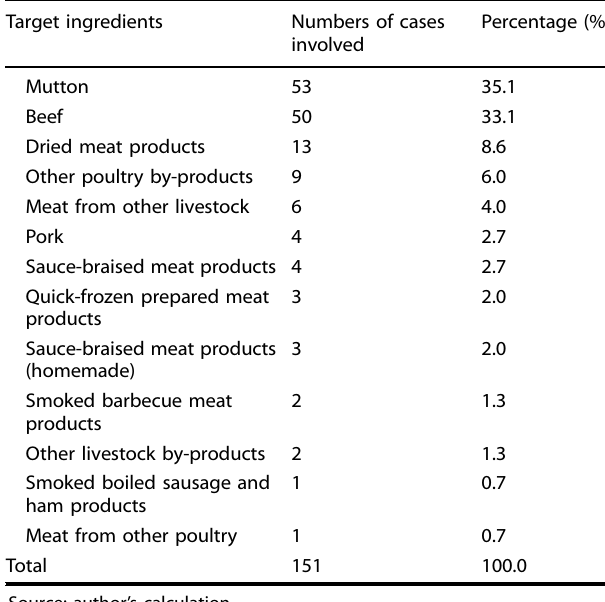
Table 4. Main target meat foods substituted by other animal-derived